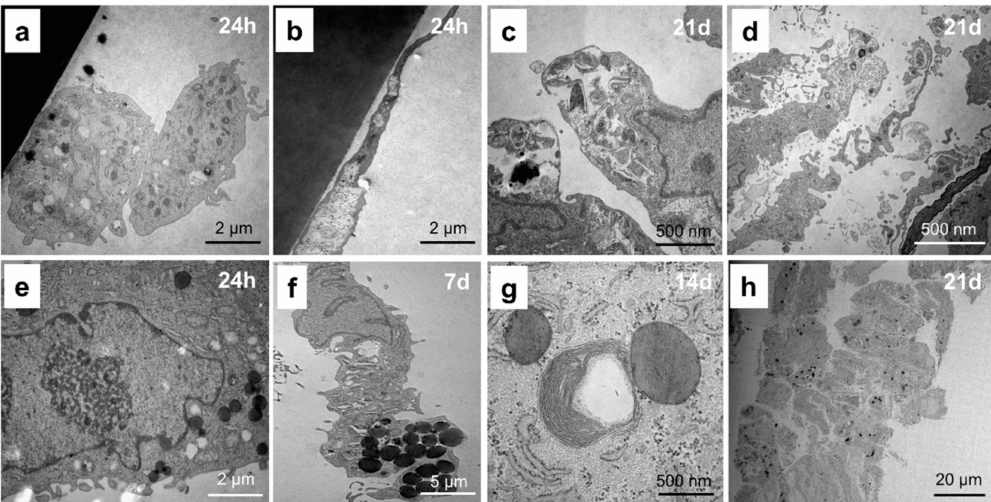
Figure 2. Morphological characteristics of chondrocytes analyzed by transmission electron microscopy. ( a ) Two chondrocytes cultivated for 24 h in DMEM / F-12 medium. ( b ) Partially edematous cytoplasm of chondrocytes cultivated for 24 h in DMEM / F-12 medium. ( c ) Chondrocytes undergoing autolysis during the cultivation for 21 d in DMEM / F-12 medium. ( d ) Cell edema after the cultivation for 21 d in DMEM / F-12 medium. ( e ) Cell lipids (black spots) visible after the cultivation for 24 h in DMEM / F-12 medium. ( f ) Cell lipids (black spots) visible after the cultivation for 7 d in DMEM / F-12 medium. ( g ) Cell lipids (black spots) visible after the cultivation for 14 d in DMEM / F-12 medium. ( h ) Cell lipids (black spots) visible after the cultivation for 21 d in DMEM / F-12